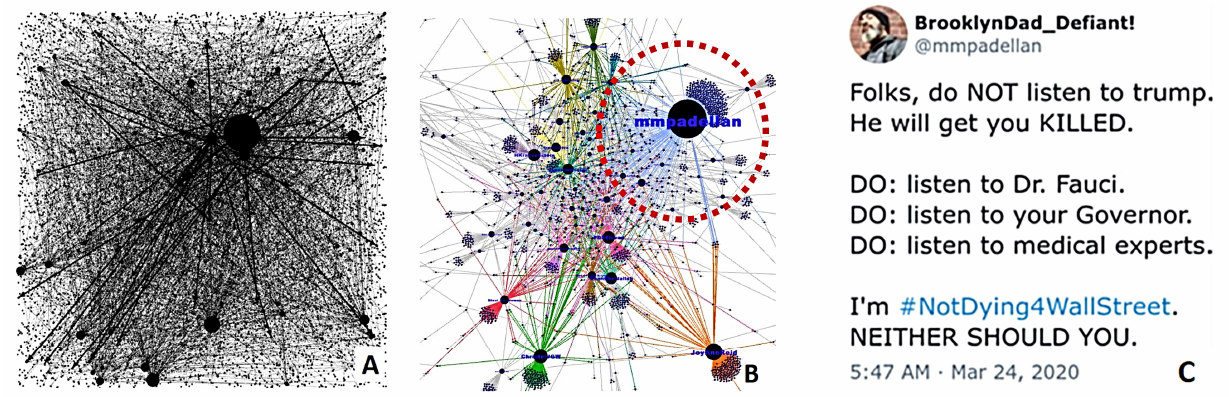
Figure 3. Screenshots A and B show the network in Gephi and C is tweeted by mmpadellan [163]. As visible in the screenshot in the middle, the network’s layout is dominated by a blue cluster from the account mmpadellan, who expressed his solidarity with the hashtag #NotDying4Wallstreet and gave advice on trustworthy persons during the pandemic by claiming that the people should listen to medical experts, their governors, and Fauci